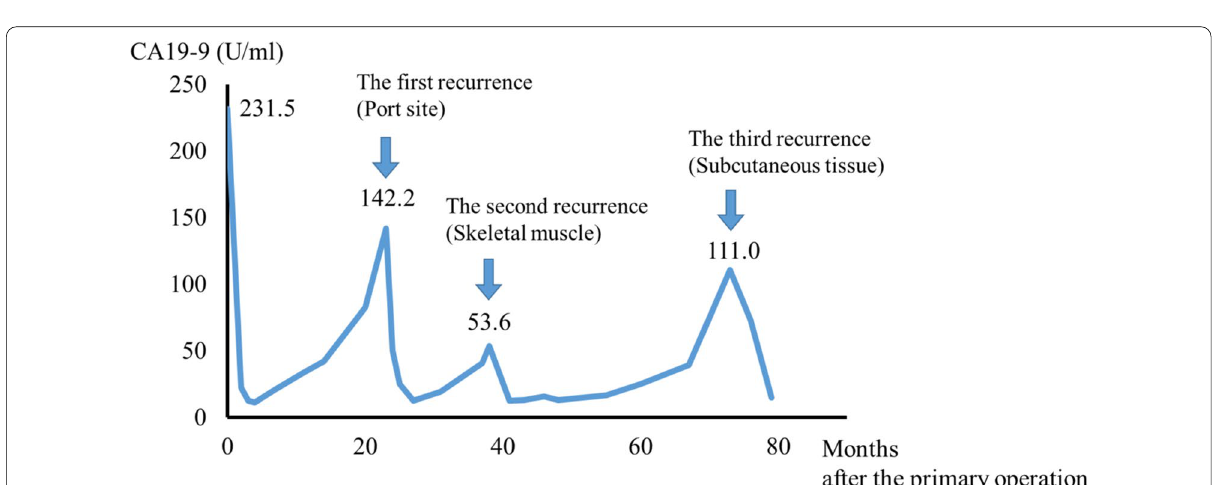
M male, por poorly differentiated adenocarcinoma, tub2 moderately differentiated adenocarcinoma, 5-FU 5-fluorouracil, N/A not